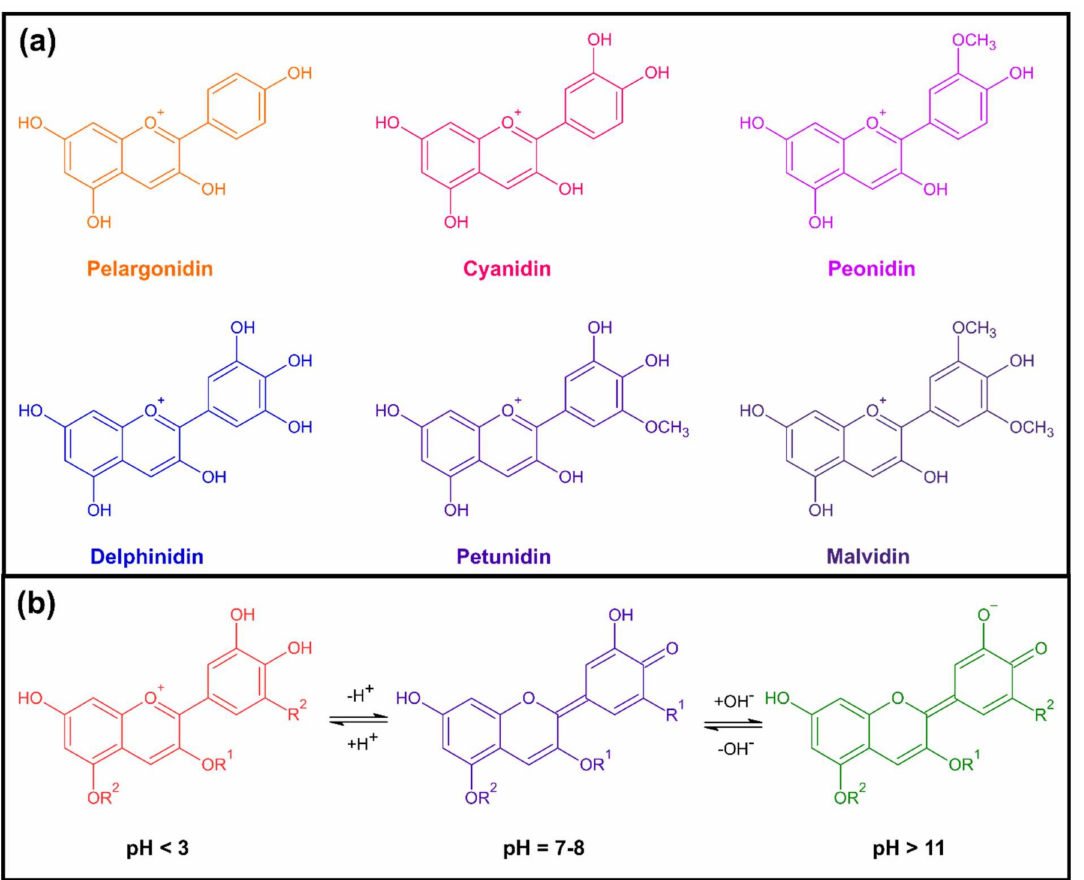
Figure 1. ( a ) The 6 main anthocyanidins and ( b ) the structure of pH changing anthocyanins. The color with which the structures are represented in the figure is resembling their real